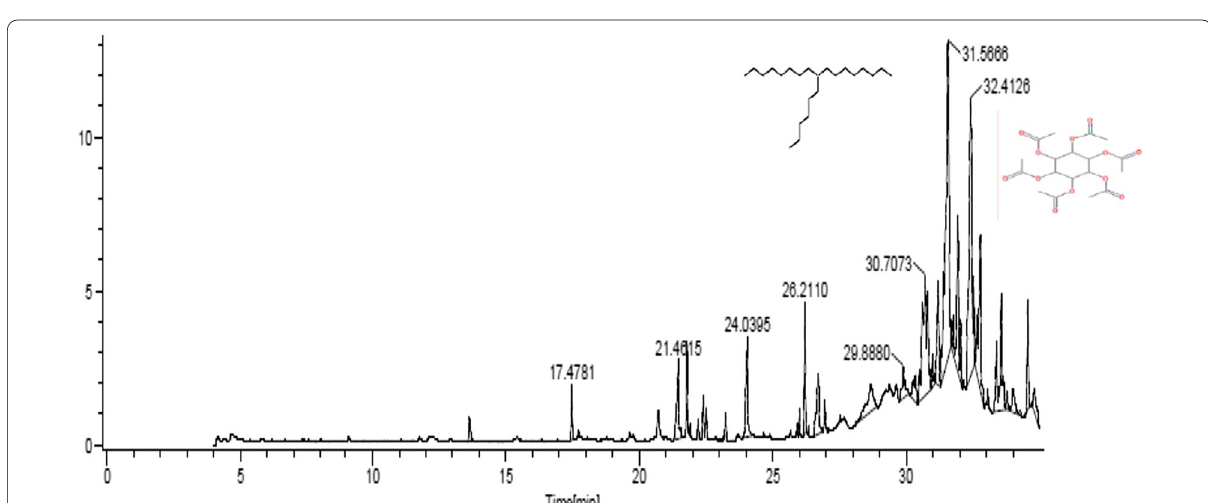
Fig. 1 GC–MS chromatogram of leaf methanolic extracts of Solanum khasianum . Potent Antifungal agent Heptadecane, 9-hexyl (43.65%) and Myoinositol (15.05%), precursor of several metabolic